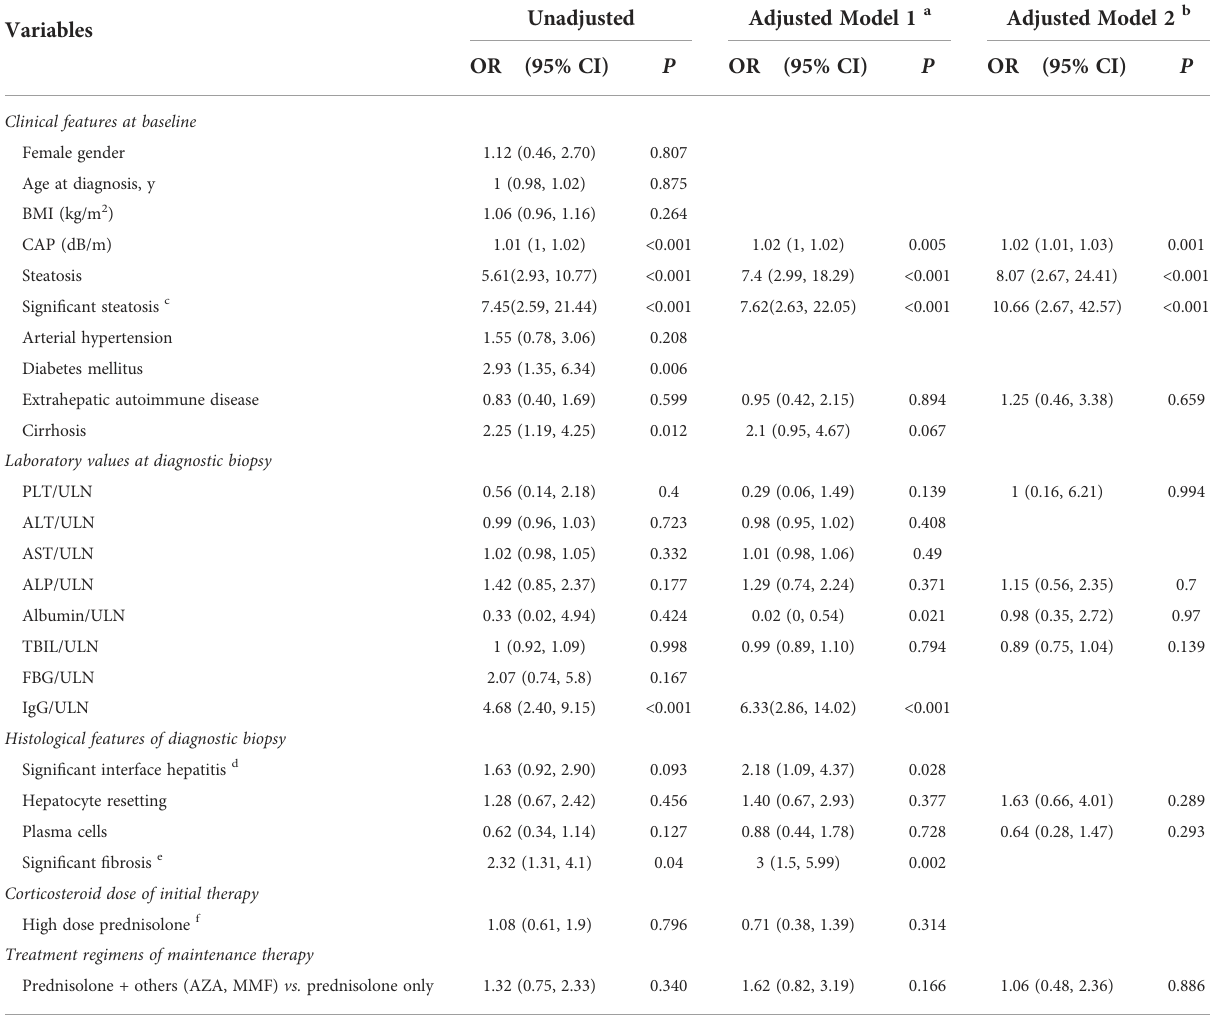
TABLE 3 Univariable and multivariable logistic regression analysis for the impact of hepatic steatosis on the risk of insuf fi cient biochemical response.